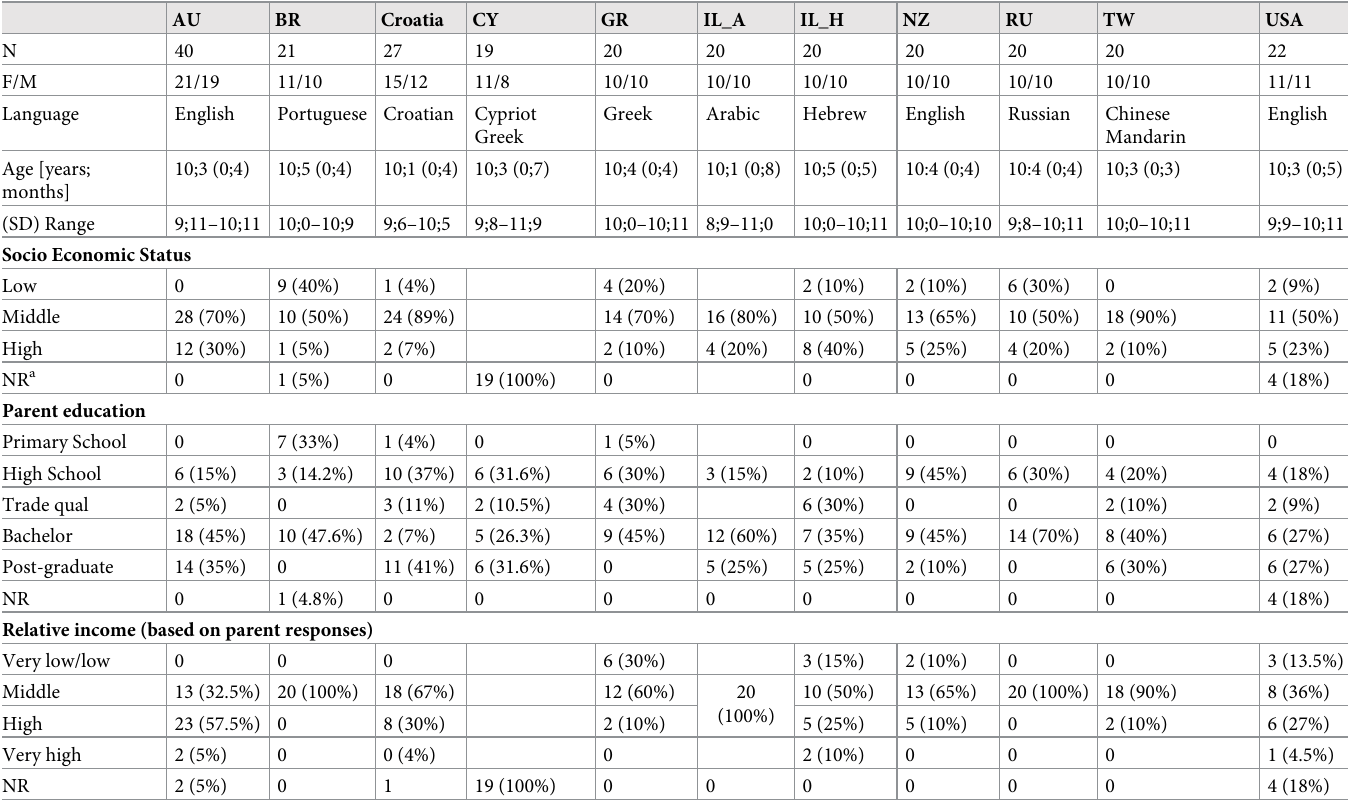
Table 1. Demographic